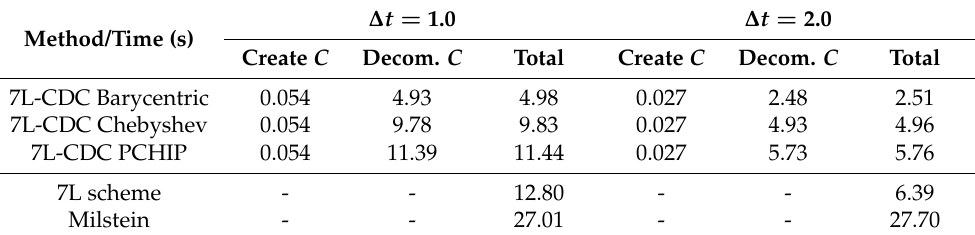
Table 3. The CPU running time (s) to reach the same accuracy (CPU: E3-1240, 3.40 GHz): simulating 10,000 sample paths until terminal time T = 4.0, based on 5 × 5 marginal/conditional SC points. Here, for the 7L scheme, PCHIP is used as the interpolant g m ( · ) in Step 3 of Algorithm 1. ∆ t = 1.0 ∆ t = 2.0 Method/Time (s) Create C Decom. C Total Create C Decom. C Total 7L-CDC Barycentric 0.054 4.93 4.98 0.027 2.48 2.51 7L-CDC Chebyshev 0.054 9.78 9.83 0.027 4.93 4.96 7L-CDC PCHIP 0.054 11.39 11.44 0.027 5.73 5.76 7L scheme - - 12.80 - - 6.39 Milstein - - 27.01 - -